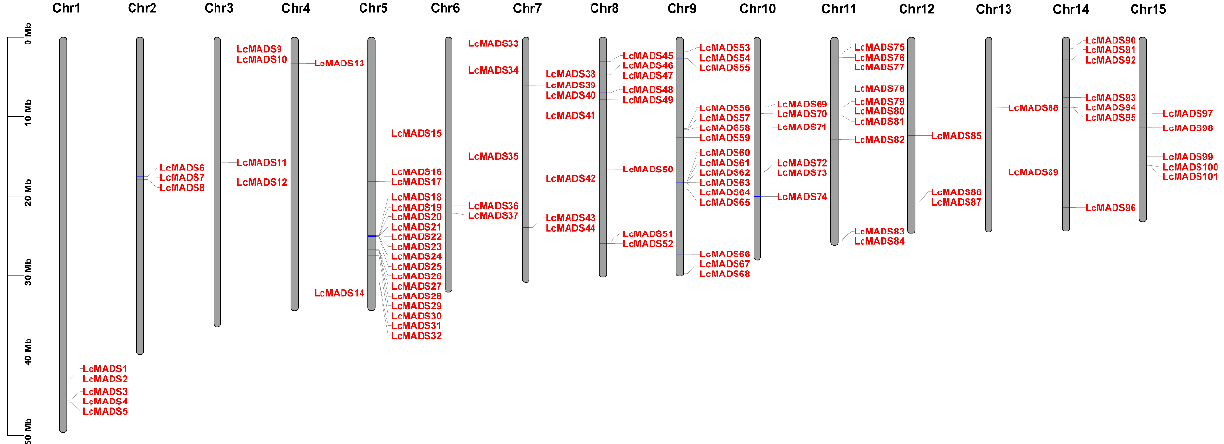
Figure 1. Schematic representations of the chromosomal location of litchi MADS-box genes. The chromosome number is indicated at the top of each chromosome.